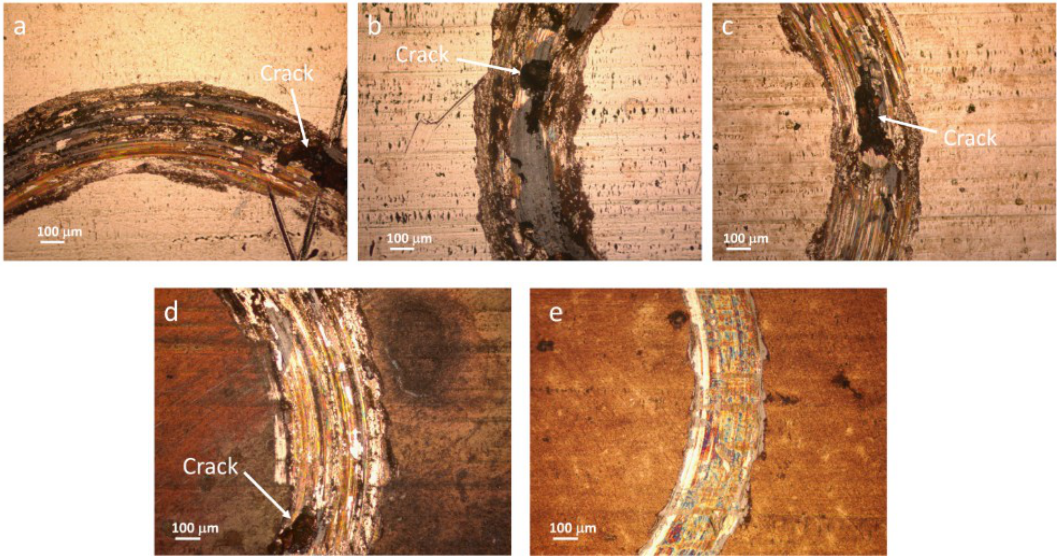
Figure 6. Optical micrographs of the wear track of the as-deposited Fe-24W samples ( a ), and of the wear tracks of samples annealed at 200 °C ( b ), 400 °C ( c ), 600 °C ( d ) and 800 °C ( e ). In the images the presence of deep cracks (i.e., 15 μm) is highlighted with an arrow.